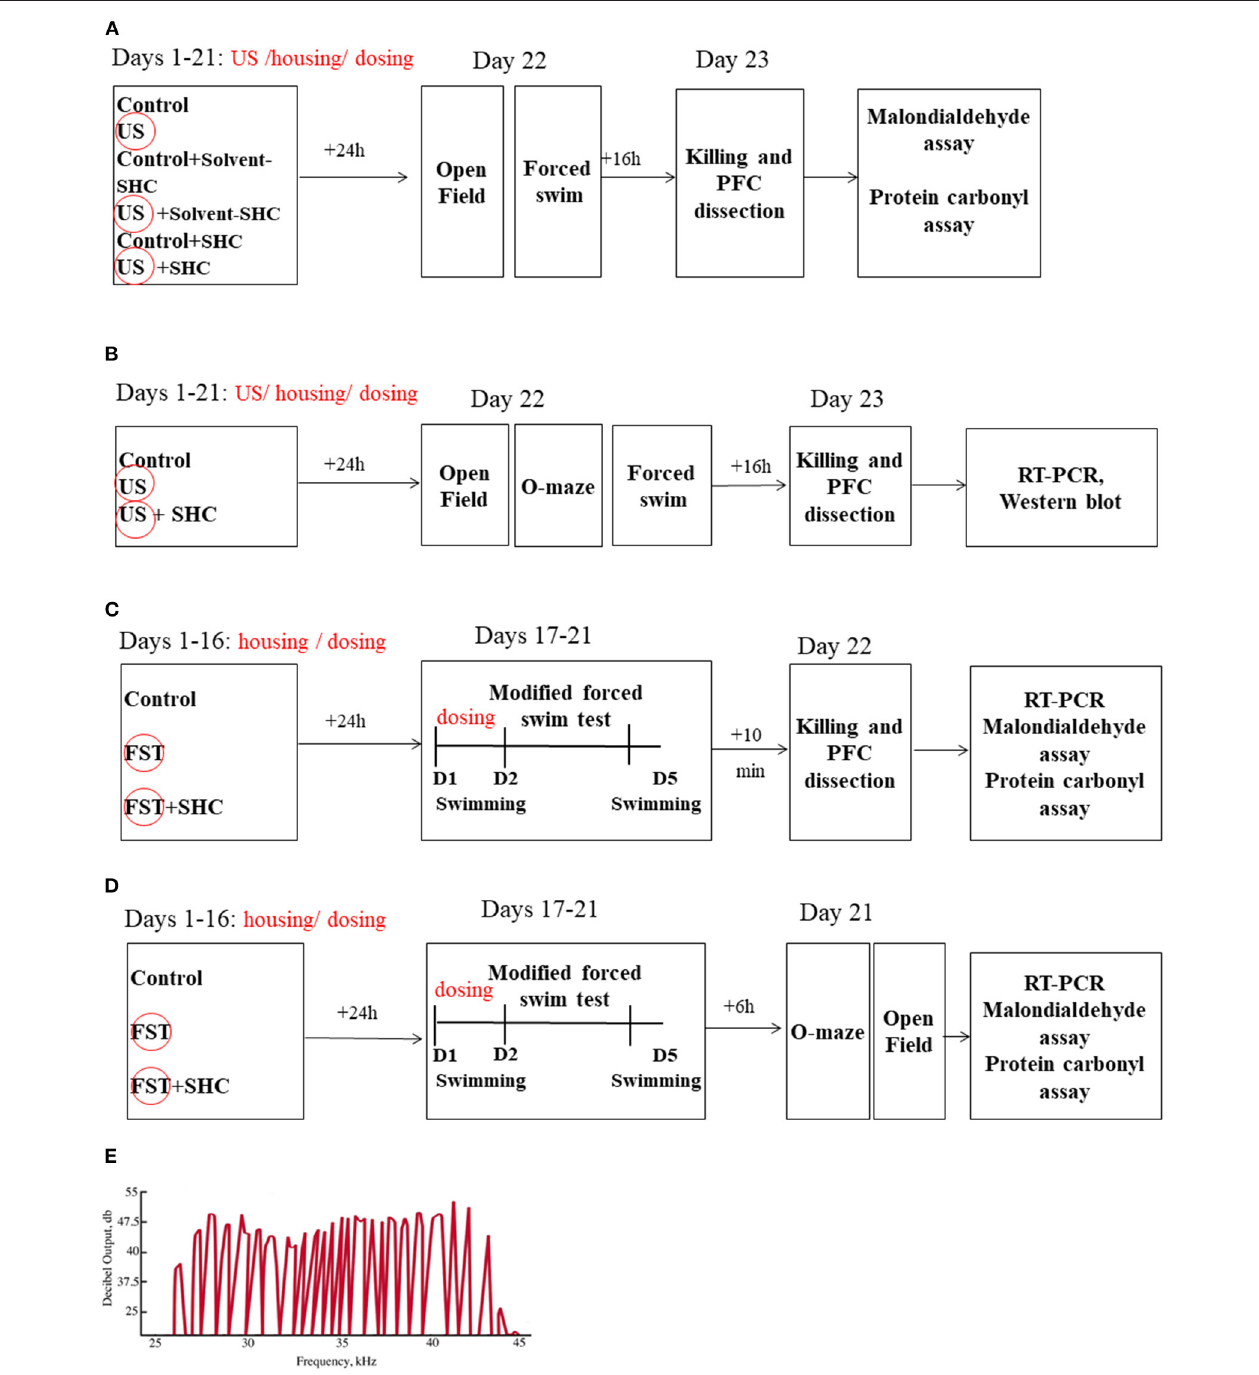
FIGURE 1 | Study flow. (A) BALB/c mice remained unstressed or were submitted to US for three weeks; they were either nontreated or received SHC solvent or SHC ( n = 7 per group). Thereafter, mice were weighed and studied for the open field and forced swim tests and consequently killed; their prefrontal cortex was dissected for the MDA and protein carbonyl assays. (B) Following the above-described US and SHC treatment, C57BL/6 mice ( n = 8 per group) were weighed and scored for floating and open field and O-maze behaviors and consequently killed; their prefrontal cortex was dissected for the RT-PCR and Western blot examination of the expression of GSK-3 β and GSK-3 α , Akt/Akt-pSer473, IL-1 β , IL-6, and IL-15. (C) C57BL/6 mice were nontreated or pretreated with SHC for 16 days and submitted to 2-day 6-min swimming sessions (days 1 and 2), followed by an additional session on day 5. They were killed 10min after the last session together with nonmanipulated controls ( n = 10 per group); their prefrontal cortex was dissected for MDA and protein carbonyl assays. (D) In the modFST, C57BL/6 mice were pretreated with SHC for 16 days and subjected to swimming sessions as described above ( n = 7 in each group). They were studied for anxiety-like behavior in the O-maze and the open field and sacrificed 10min after the last test for MDA assay of the prefrontal cortex. (E) The shape of the ultrasound signals was fluctuating, mimicking natural ultrasonic vocalizations of rodents. PFC, prefrontal cortex; FST, forced swim test; D, Day. US/FST-exposed groups are highlighted with a circle.